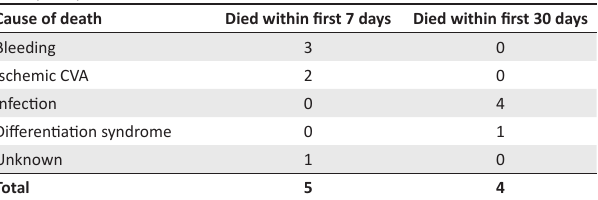
TABLE 6b: Comparison between the demographic and laboratory parameters with the short-term (7- and 30-day) outcome of patients with acute promyelocytic